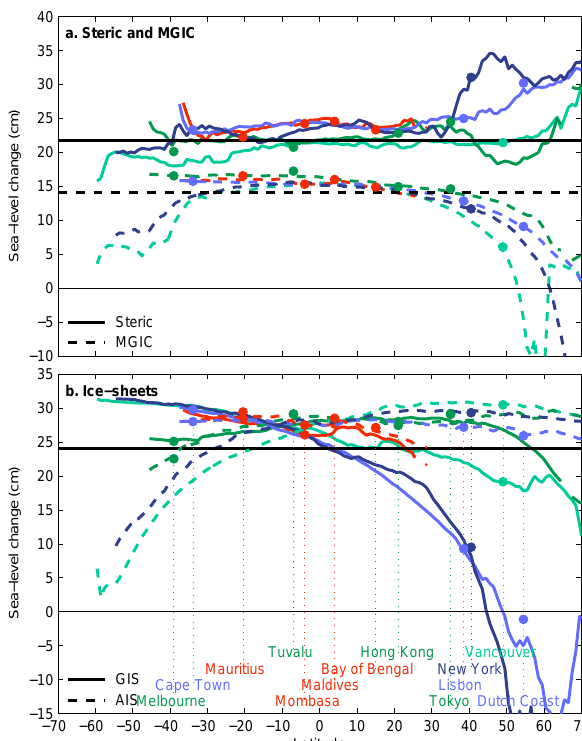
Fig. 10. Projected contributions to sea level rise along world coast- lines for the RCP 4.5 scenario. (a) Solid coloured lines show re- gional sea level change due to steric expansion and dashed lines the MGIC melt; and (b) ice sheets wastage (GIS: solid line, AIS: dashed line) in the semi-empirical case, averaged over coastal ar- eas, and for various oceans. Global mean contributions (cm) are indicated by a thick horizontal black line (see also caption of Fig. 9 for more details).